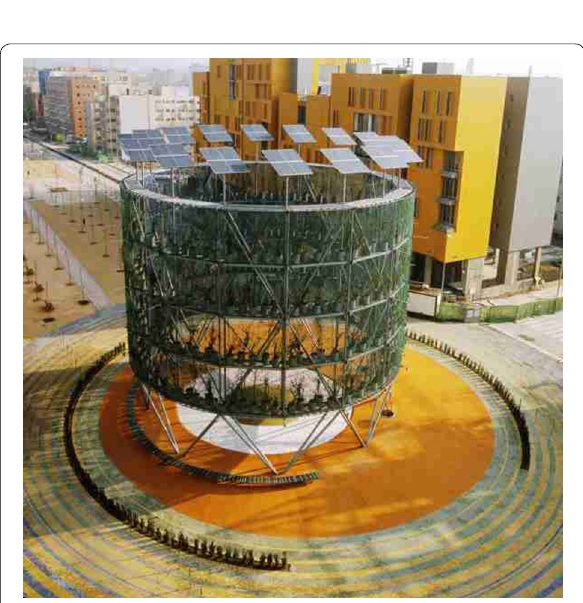
Fig. 5 Eco-Boulevard, Madrid: temporary systems for urban requalification (from http://ecosi stema urban o.com/portf olio/ eco-boule vard/). They can also be transportable generators and/or for emergencies